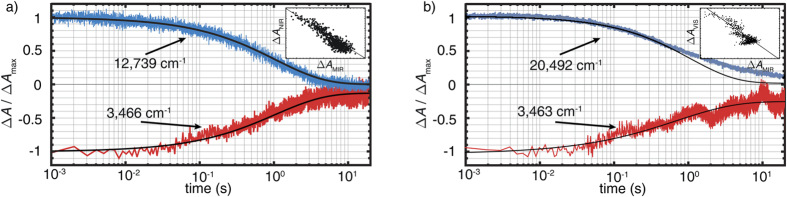
Relaxation dynamics probed at (a) 3,466 cm−1 (MIR) and 12,739 cm−1 (λ = 785 nm, NIR) and (b) at 3,463 cm−1 (MIR, inverted) and 20,492 cm−1 (λ = 488 nm, VIS). The solid lines indicate the results of fitting stretched exponential functions to the data sets. Insert: Plot of the absorbance change (a) ΔANIR, (b) ΔAVIS as a function of ΔAMIR; a linear dependence is revealed over the entire data range.